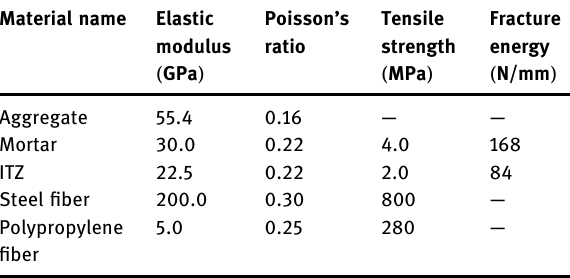
Table 2: Mechanical properties of each material